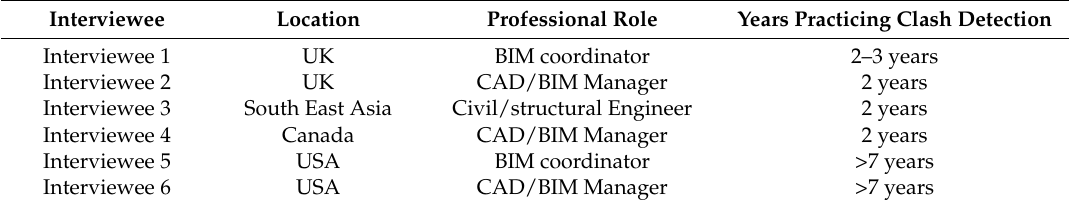
Table 7. Profile of